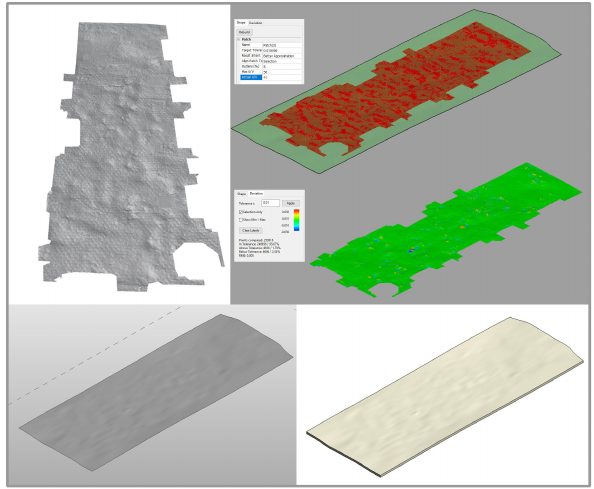
Figure 9. From the mesh to the NURBS and the creation of floor in BIM environment